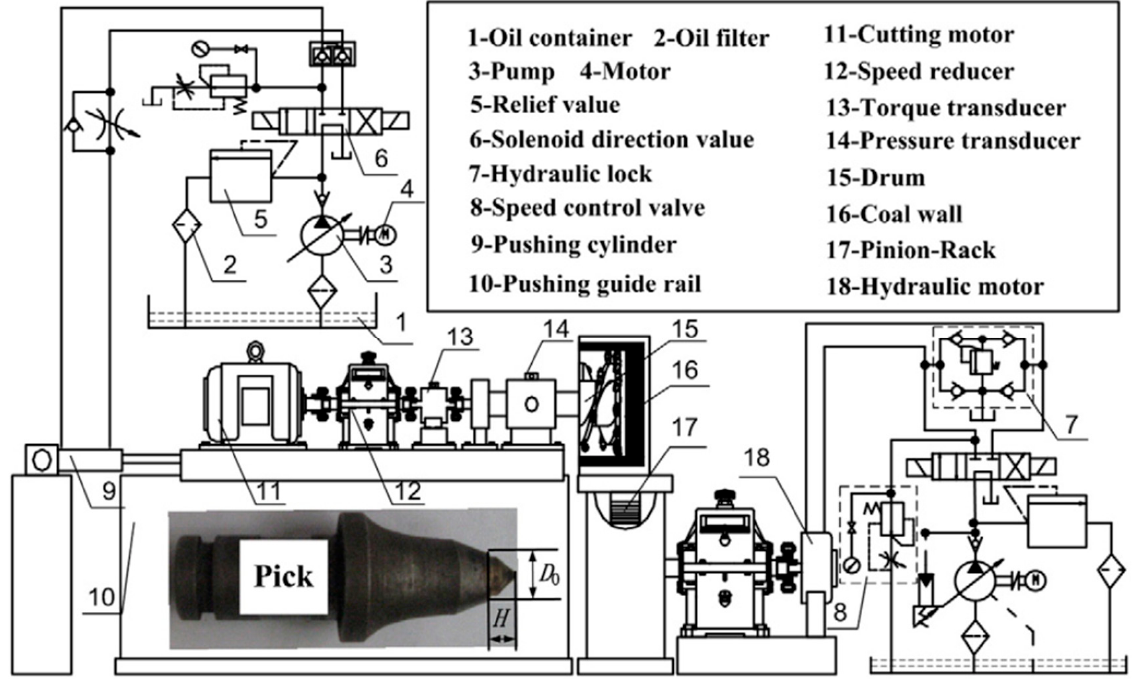
Figure 11. Revolving cutting bench at the CUMT [65].